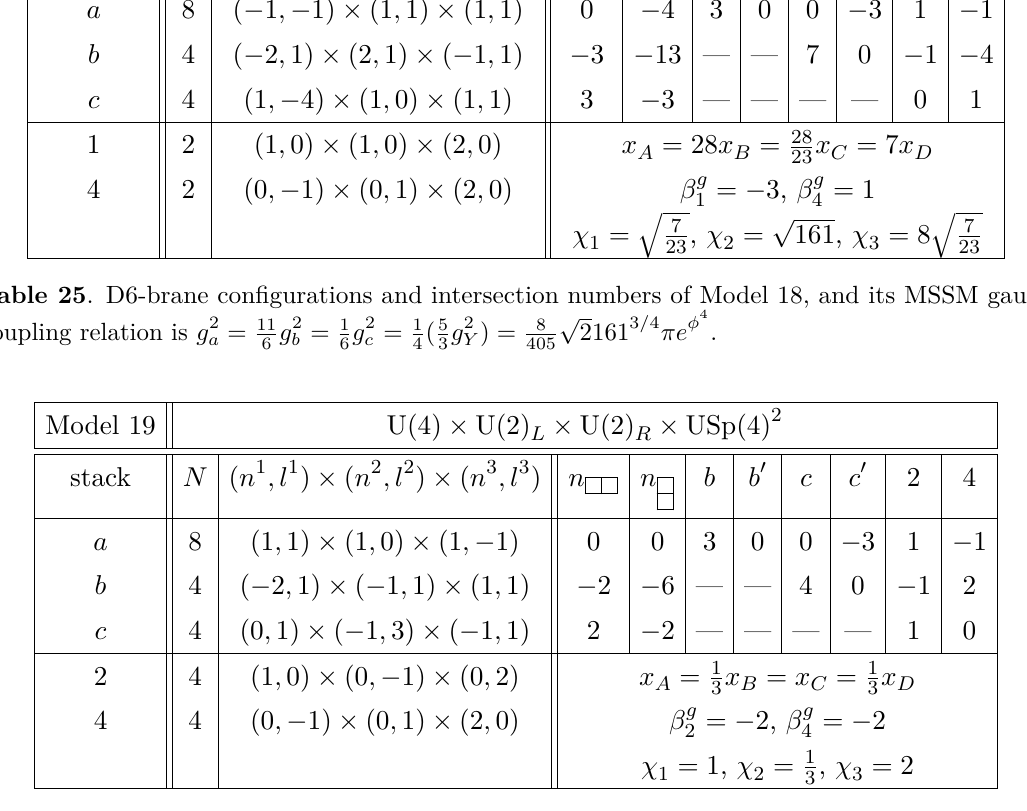
Table 26 . D6-brane configurations and intersection numbers of Model 19, and its MSSM gauge